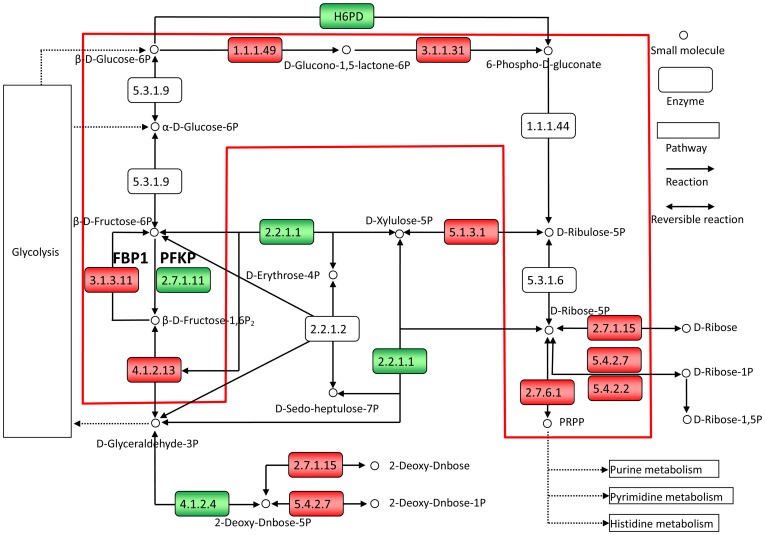
Downregulation of PFKP and upregulation of FBP1 contribute to ER+ breast cancers.ER+ DE genes in the pentose phosphate pathway are denoted in red for upregulation and in green for downregulation. The red frame indicates the elevated oxidative subpathway of the pentose phosphate pathway in ER+ cancers. The figure is created based on KEGG pathway hsa00030. Only a part of the pathway is shown for clarity.